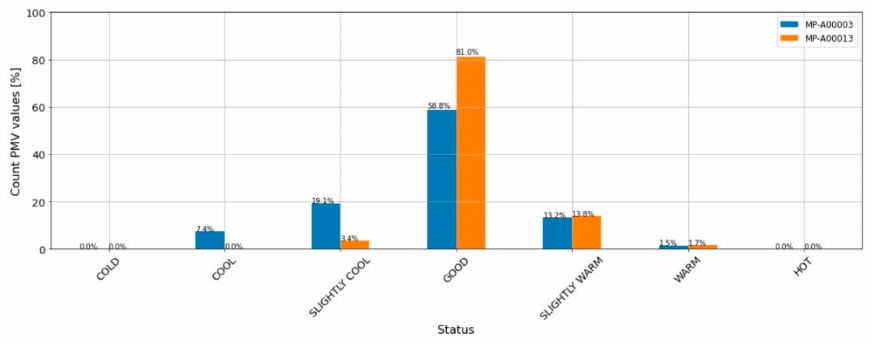
Figure 16. PMV percentage distribution for the defined ranges (MP-A00003 and MP-A00013). Finally, both users periodically provided feedback regarding their actual